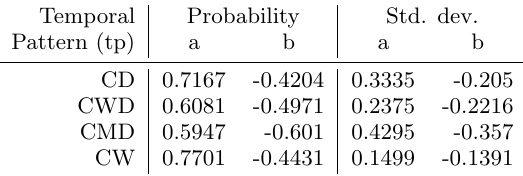
Table 3: Probability Function Parameters Temporal Std.